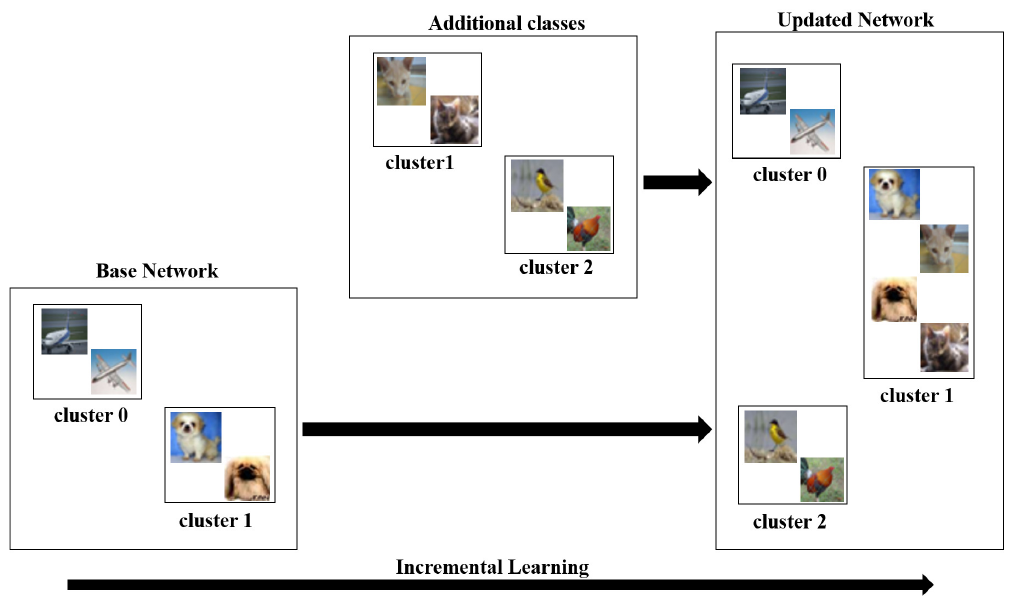
Figure 1. Example of Incremental